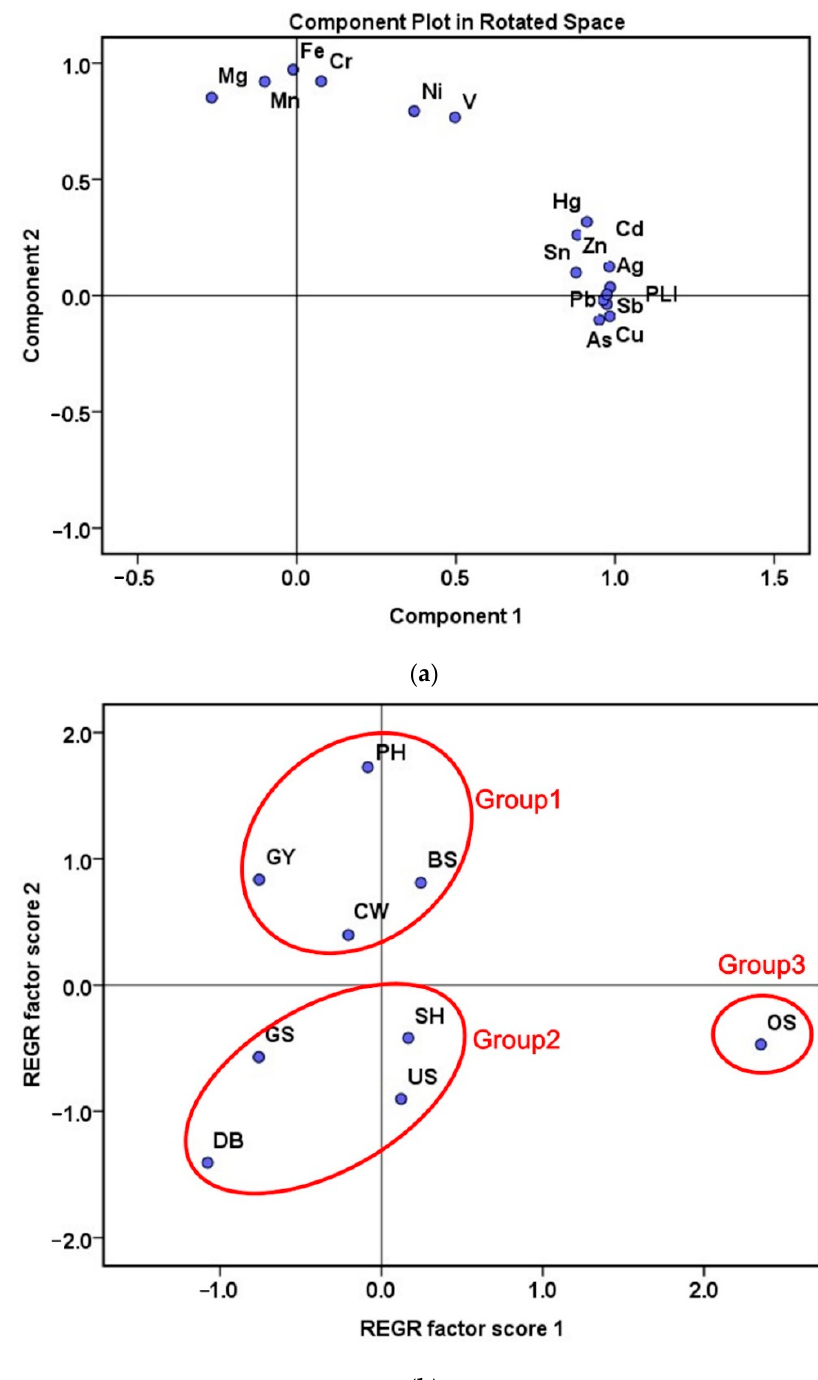
Figure 2. PCA results for identifying the pollution sources that mainly affect the PM10 of RDS and classification of the pollution characteristics by ICs. ( a ) Loading plot of the two principal components, ( b ) graph plotted with regression factors of PC1 and PC2.